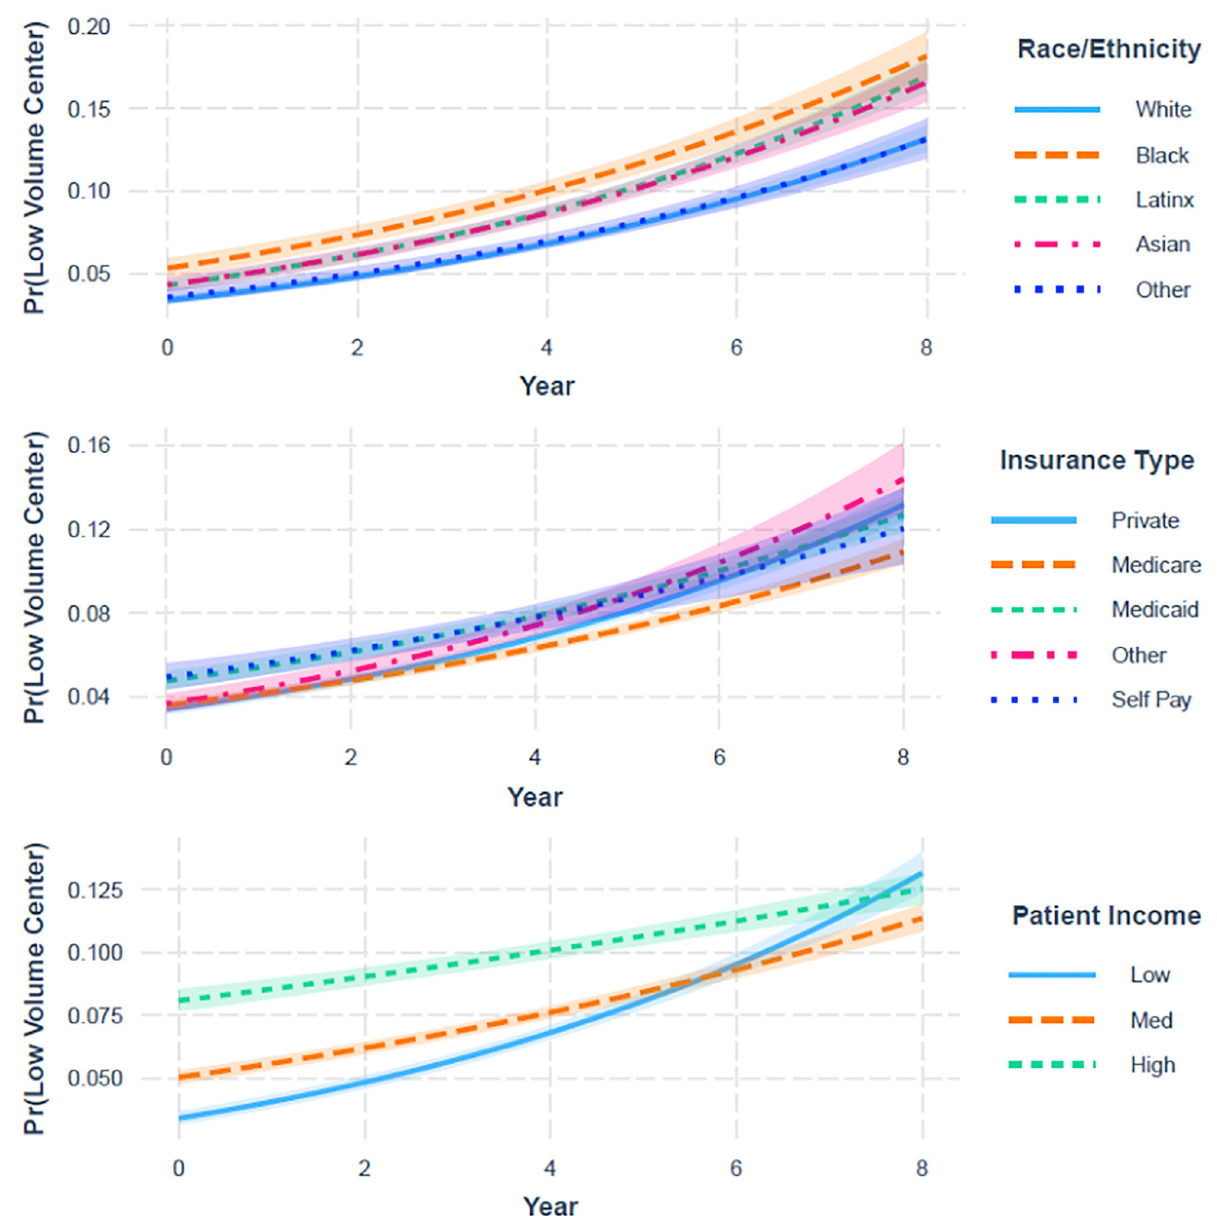
Fig 3. Probability of visiting a low-volume hospital over time by sociodemographic subgroup.